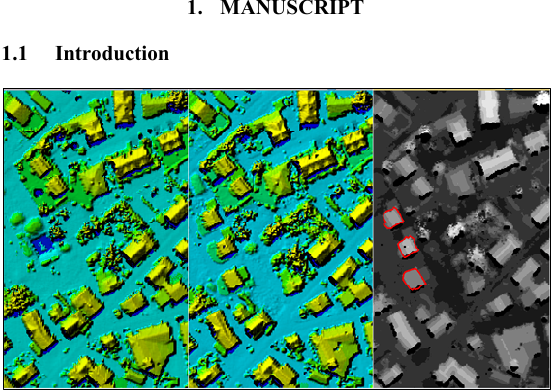
Figure 1. (Left, Center) Hillshaded point clouds from November 2008 and September 2009, (Right) Point cloud indicating new